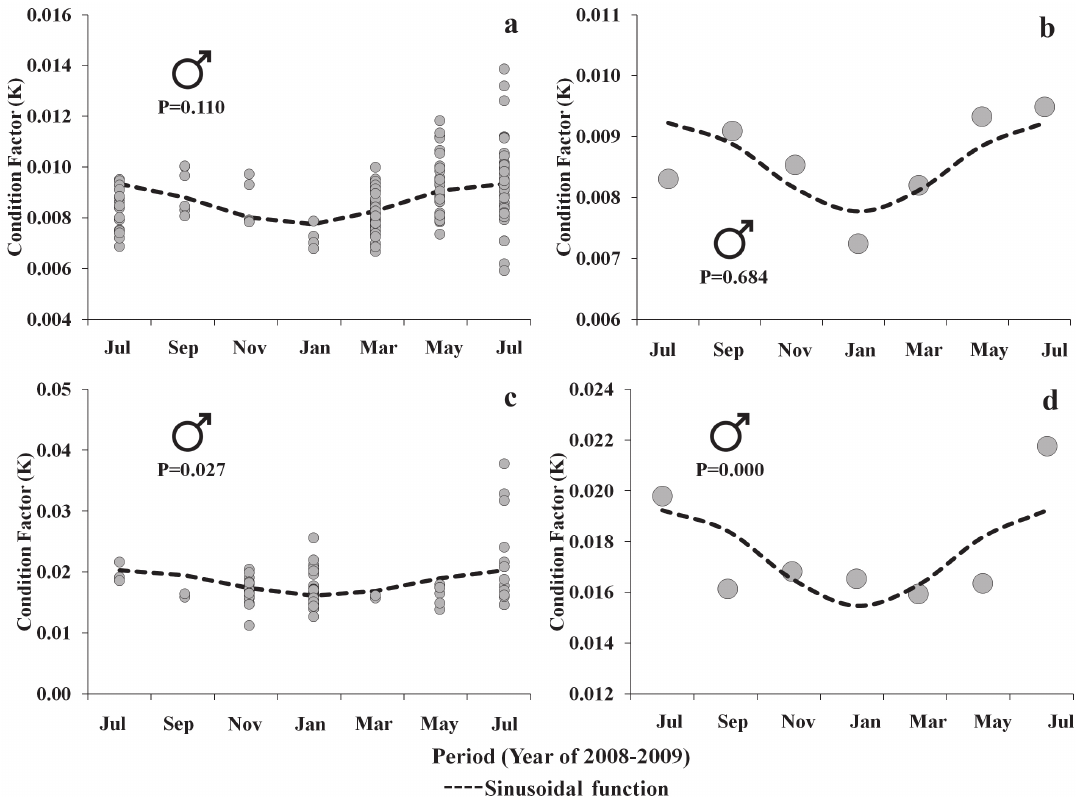
Fig. 5. Bimonthly variation in the raw data ( a , c ) and mean values ( b , d ) for the condition factor (K) in juvenile ( a , b ) and adult ( c , d ) male of the Auchenipterichthys longimanus collected from July 2008 to July 2009 in the Caxiuanã National